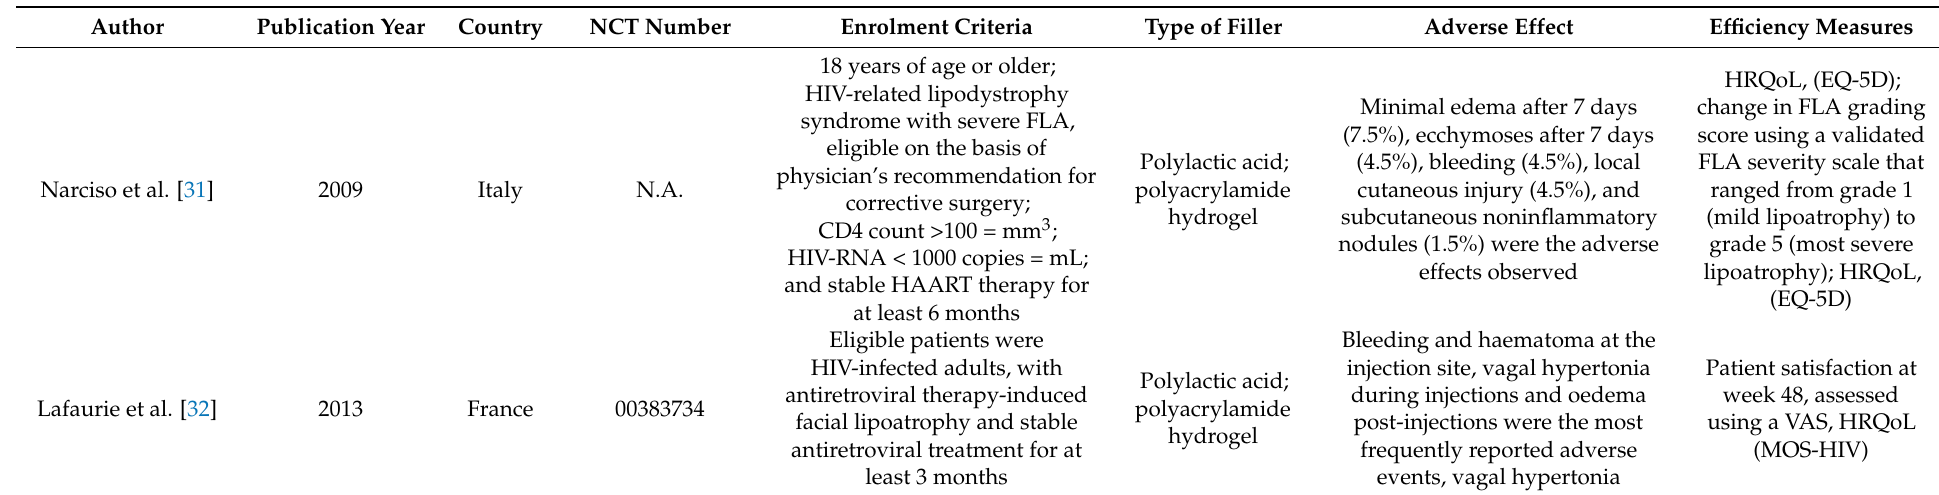
Table 1. General findings of included